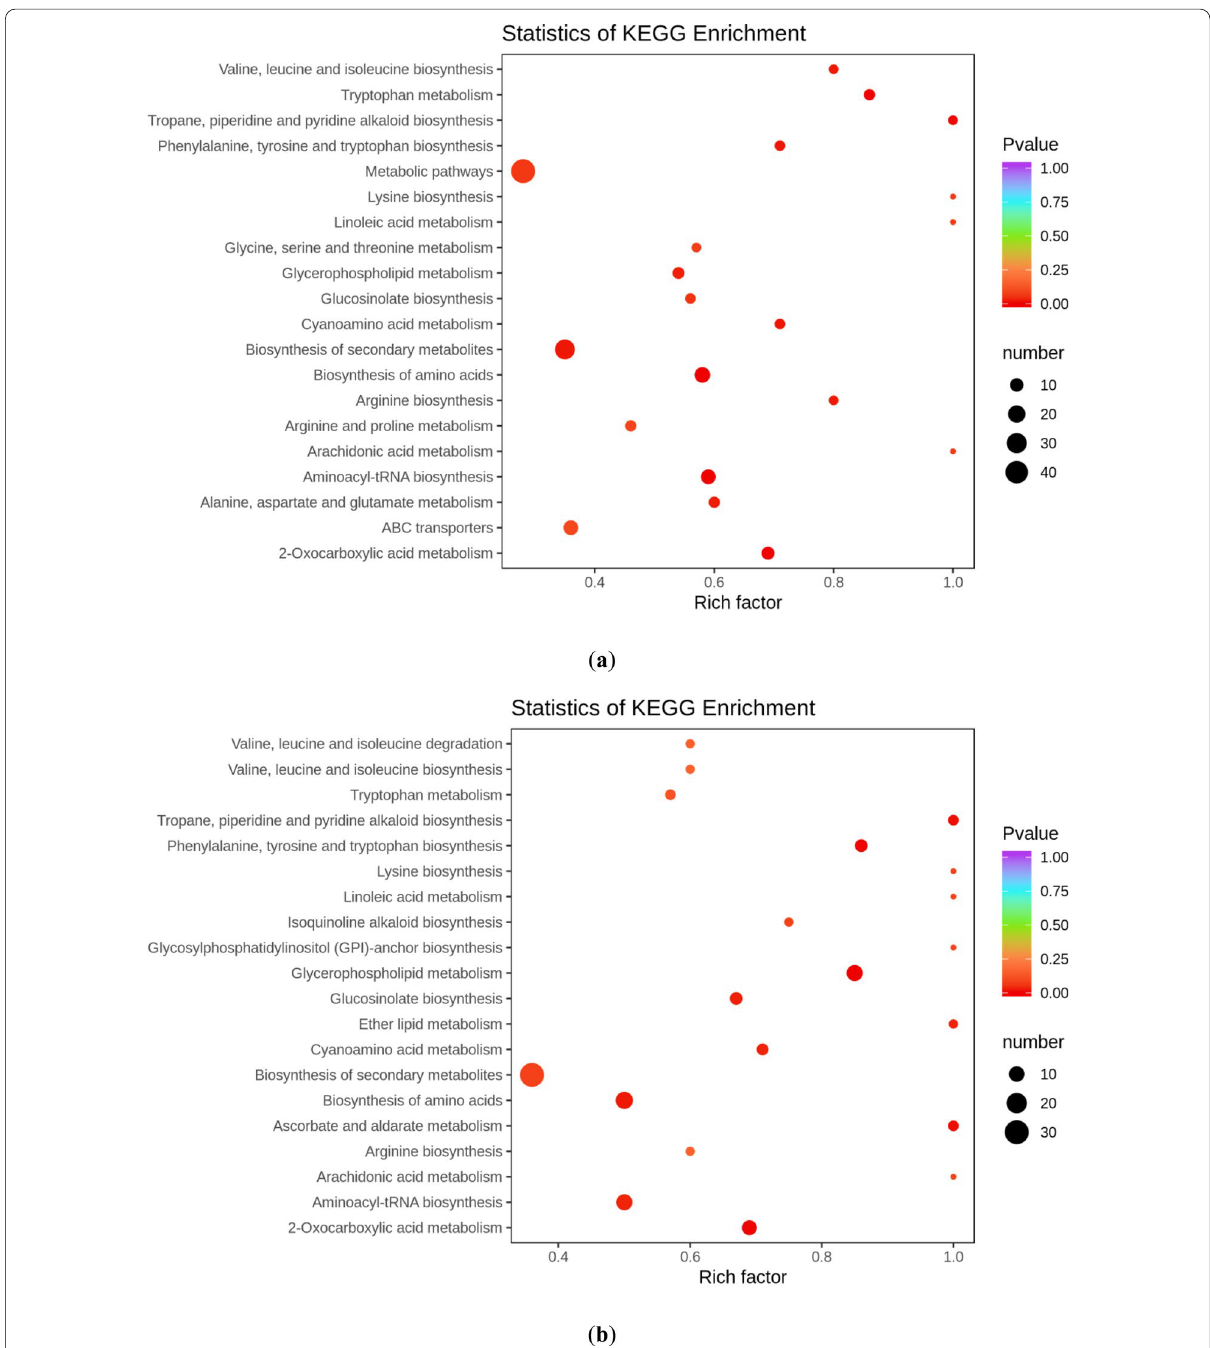
Fig. 8 KEGG enrichment diagrams of differential metabolites. a HN44-CK vs. HN44-DS; b HN65-CK vs. HN65-DS. The abscissa represents the Rich factor corresponding to each pathway, the ordinate is the pathway name, the color of the point is the pvalue, and the redder the more significant the enrichment. The size of the dots represents the number of enriched differential